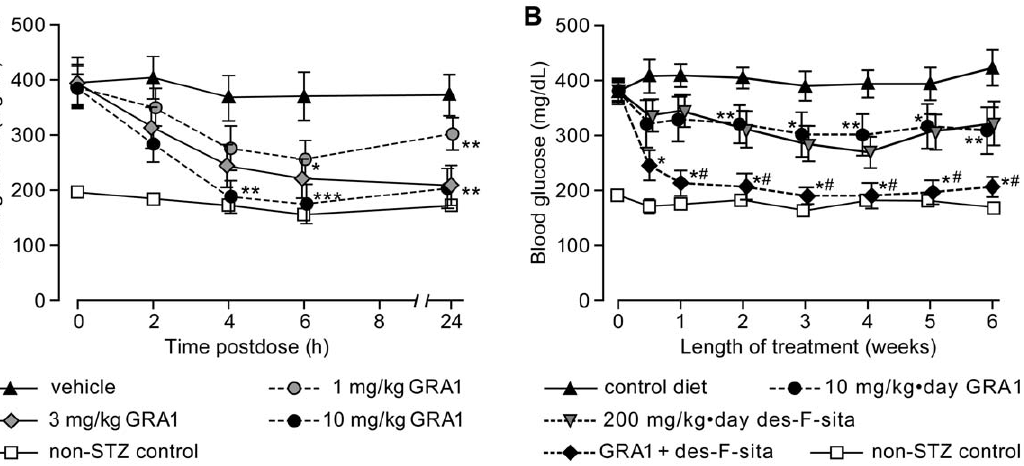
Figure 5. GRA1 lowers glucose in hGCGR HFD/STZ mice and further enhances the efficacy of a DPP-4 inhibitor. (A) Mean ( 6 SEM) blood glucose hGCGR HFD/STZ mice treated with a single dose of 1, 3, or 10 mg/kg GRA1. (B) Non-fasted blood glucose concentrations in hGCGR HFD/STZ mice treated for 6 weeks with 10 mg/kg ? day GRA1, 200 mg/kg ? day des-fluoro-sitagliptin (des-F-sita), or the two agents in combination. (Additional data from this study are in Table 4.) *p , 0.05, **p , 0.01, and ***p , 0.001 versus HFD/STZ controls; # non-significant (p . 0.05) versus non-STZ controls; n=8–15 animals per group. doi:10.1371/journal.pone.0049572.g005 PLOS ONE |